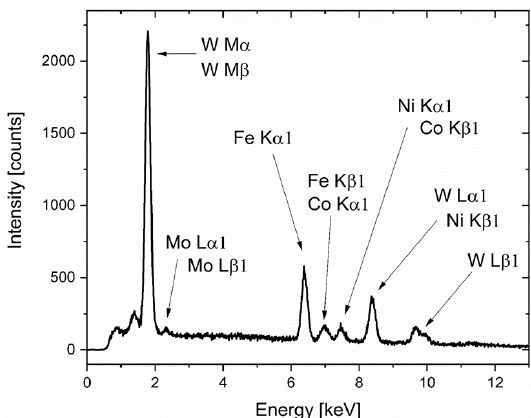
Figure 7. EDS measurement of the interphase. The spectrum contains all measurable elements of the